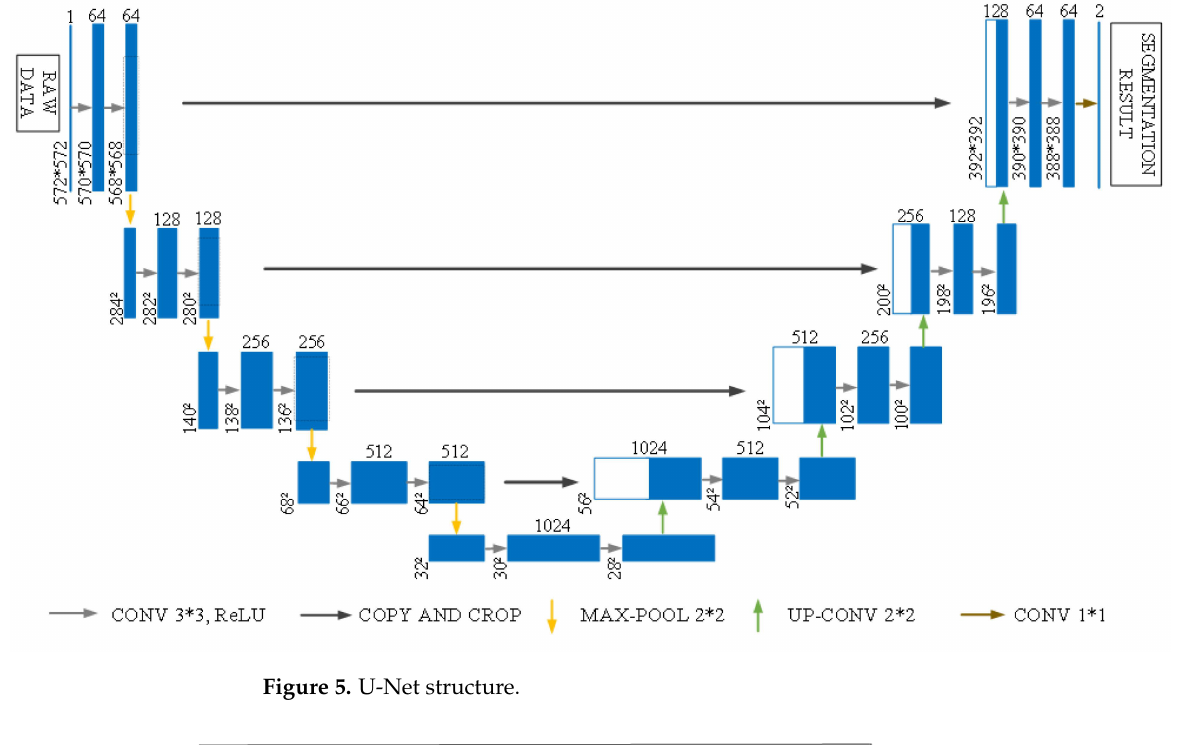
Figure 5. U-Net structure.